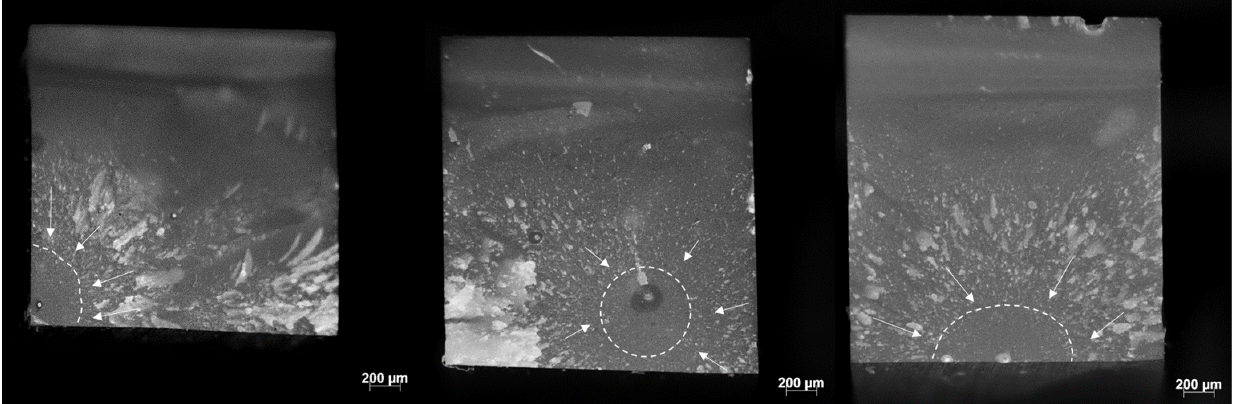
Figure 4. Representative images of the three identified fracture origins in the analyzed materials, from left to right: corner (surface), sub-surface (volume), and edge defect (surface). The fracture mirror (smooth surface in the initial part of the fracture created when the crack is accelerated) is marked by a dashed line, with arrows pointing to the origin of the fracture. The rougher surface adjacent to the mirror (mist) is followed by crack propagation in different directions, resulting in radial striations (hackle lines).